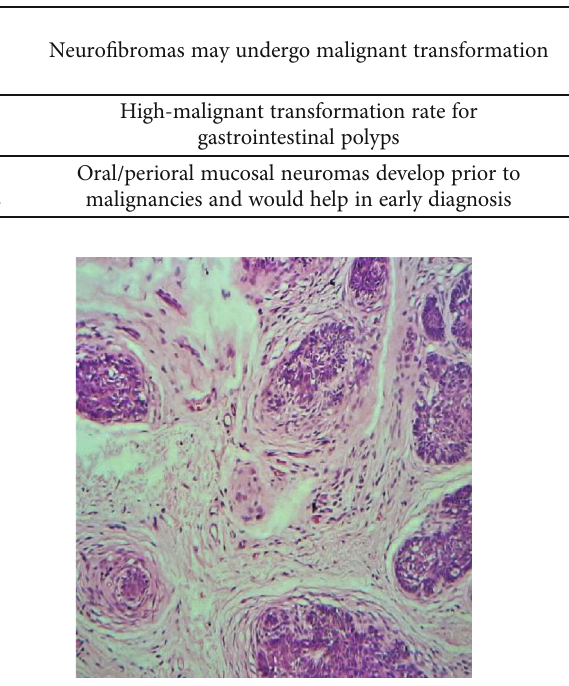
Figure 5: Pictomicrograph of the symmetrical adnexal tumour composed of lobules of basaloid cells and keratocytes (H&E, low power, ∗ 10).